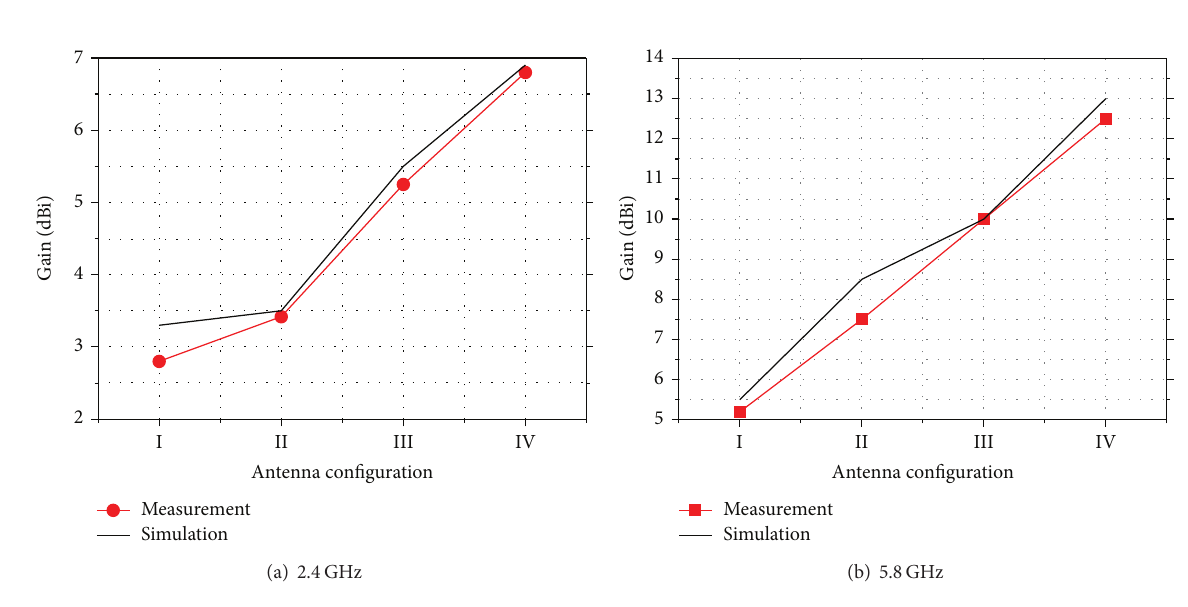
Figure 10: Measured elevation patterns from configuration IV.